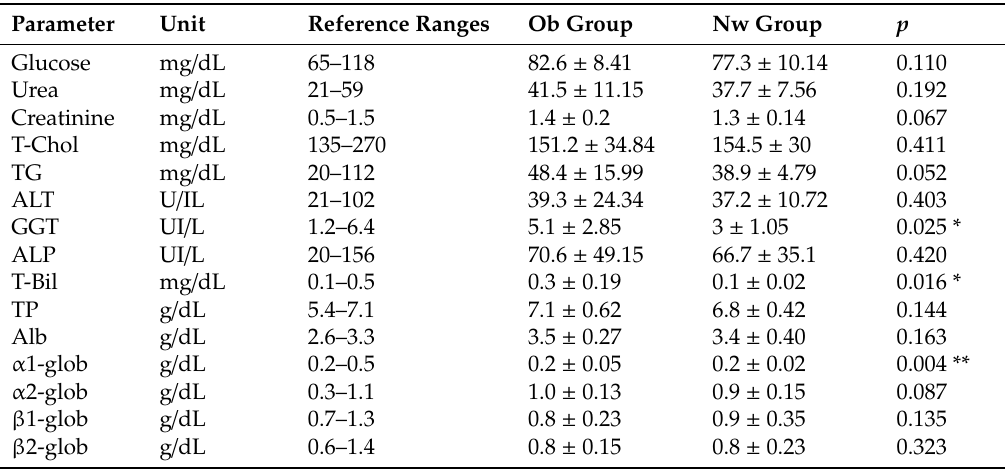
Table 4. Serum biochemical analysis and serum LEP profile in Obese and Normal-weight